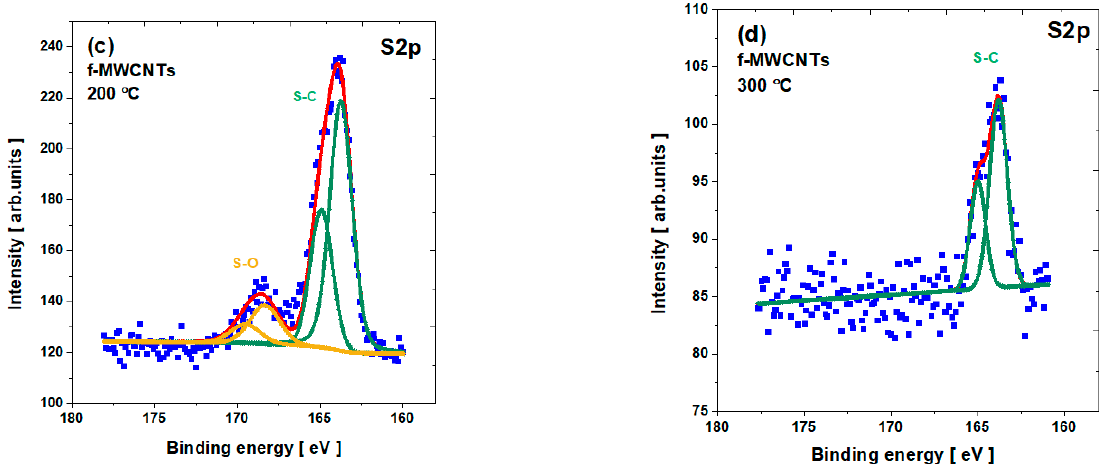
Figure 8. The S2p core level line for f-MWCNTs: ( a ) pristine; ( b ) calcined at 100 °C; ( c ) calcined at 200 °C; and ( d ) calcined at 300 °C.